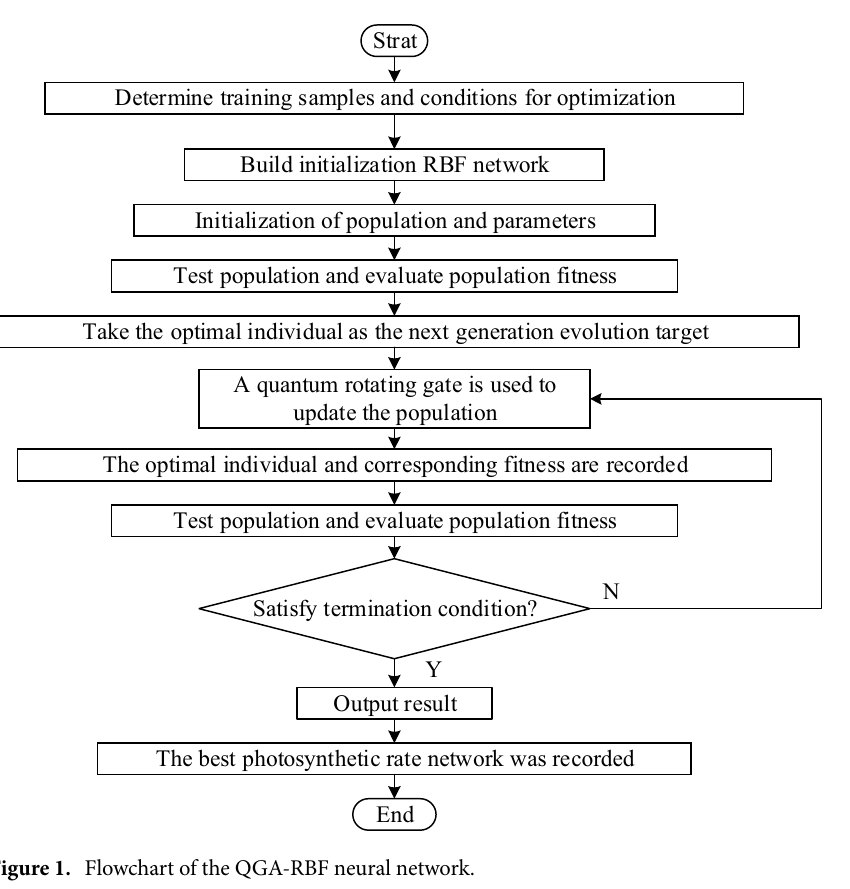
Figure 1. Flowchart of the QGA-RBF neural network.